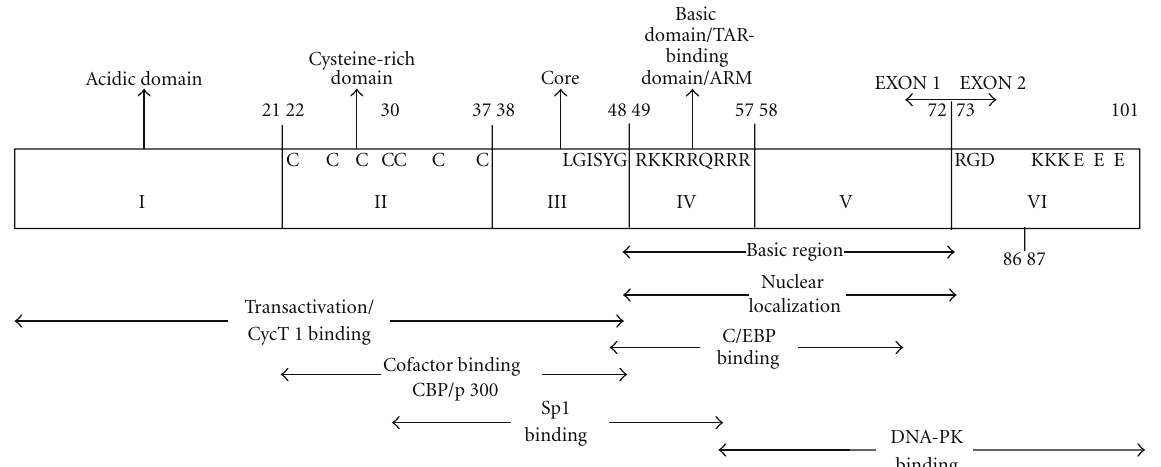
Figure 1: Schematic representation of HIV-1 Tat with locations of the six main domains indicated. Within each domain, important amino acid residues are designated. In addition, known functions of the domains or interactions with the protein involved in transcription are also